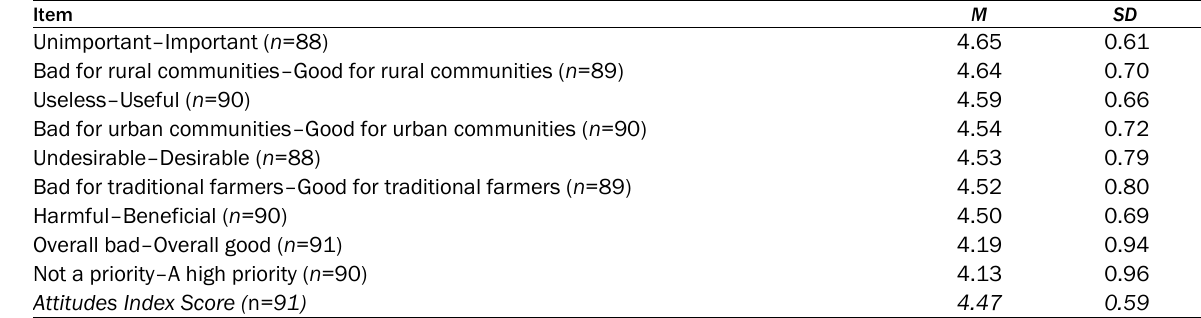
Table 4. Attitudes Toward Local Food Production Item